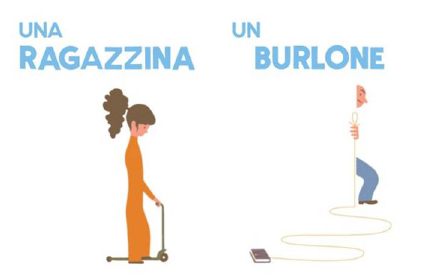
Figure 13. BlexBolex, Immaginario ; Orecchio Acerbo, Italia 2008, [13].